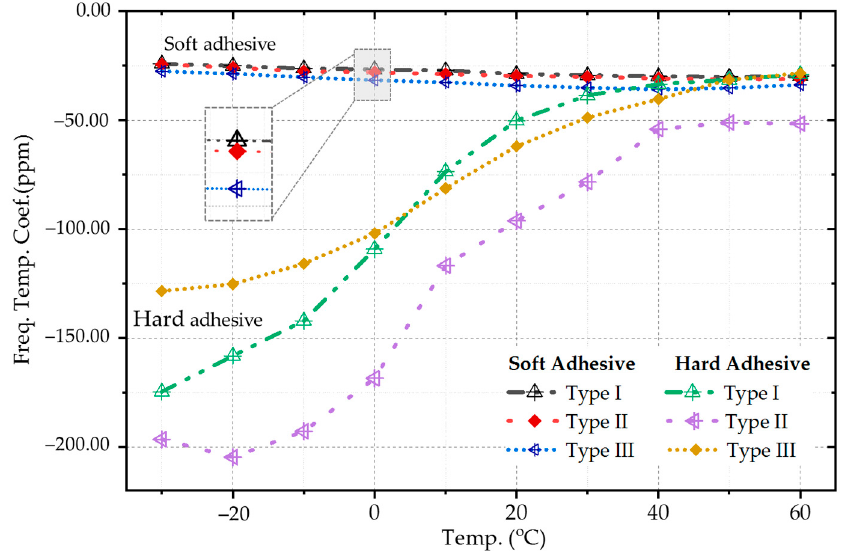
Figure 9. The frequency temperature coefficient in the test with hard & soft adhesive in three dispensing methods.